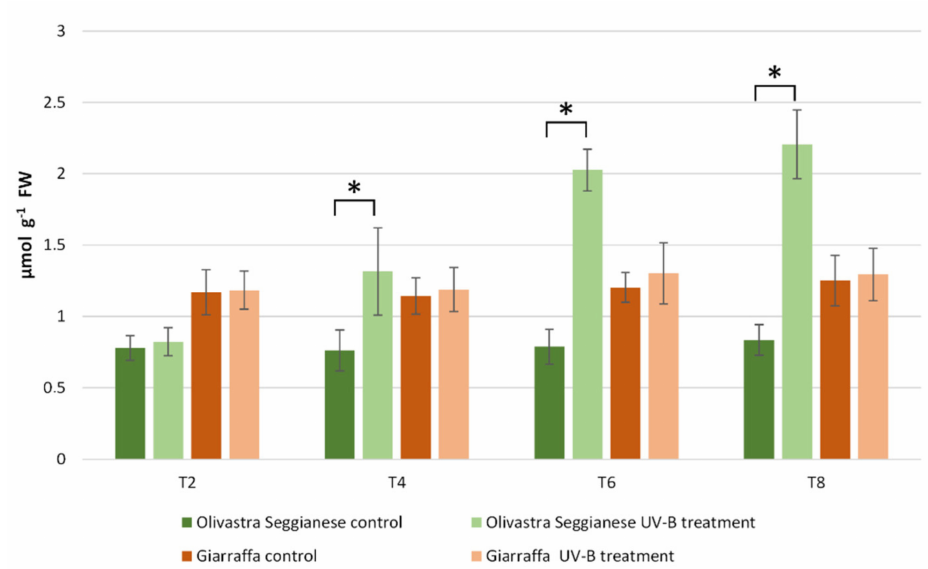
Figure 5. MDA (malondialdehyde) content in Giarraffa and Olivastra Seggianese leaves under control conditions and after exposure to UV-B treatment. Treatment times are indicated in the X -axis. The asterisks (*) indicate statistically significant differences between control and stressed samples within each variety. The two varieties differ by ANOVA test for p ≤ 0.01. Values are mean ± standard ( n = 6).